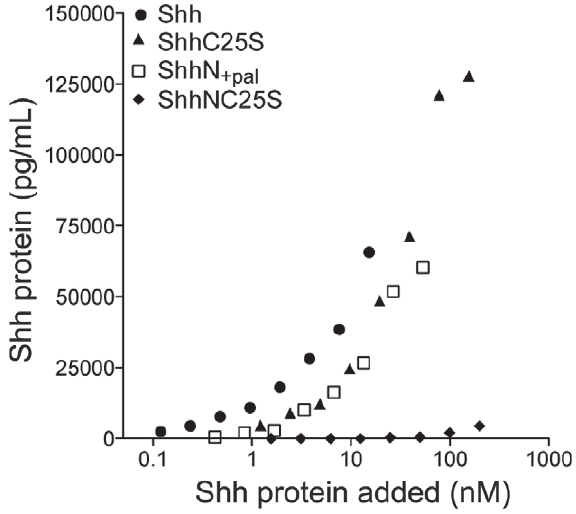
Figure 6. Lipid modification enhances Shh association with receiving cells. NIH3T3 cells were incubated at 37 u C for 42 hours with medium containing various concentrations of recombinant Shh protein. After extensive washes, the cells were lysed and analyzed by ELISA. The highest levels of protein were recovered from cell lysates following incubation with Shh-conditioned medium. Recovery of ligand was greatly diminished when both lipid adducts were removed (ShhNC25A), and restored with either cholesteryl (ShhC25S) or palmitoyl (ShhN + pal ) modification alone. Experiments were performed in replicates of four, and representative data are